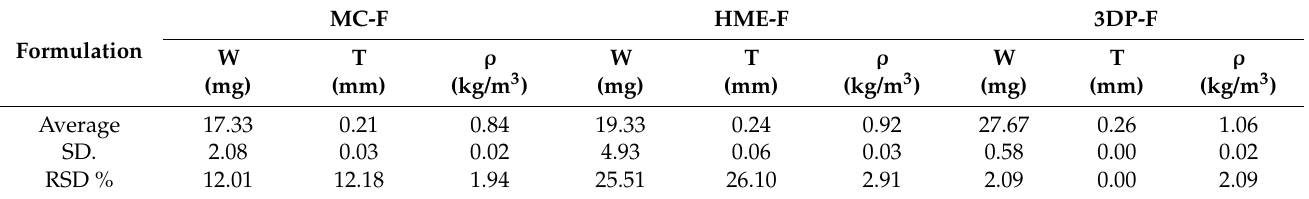
Table 1. The dimensions, weight, and calculated densities of the MC-F, HME-F, and 3DP-F. ( n = 9, arithmetic mean ± SD). MC-F HME-F Formulation Average SD. RSD %